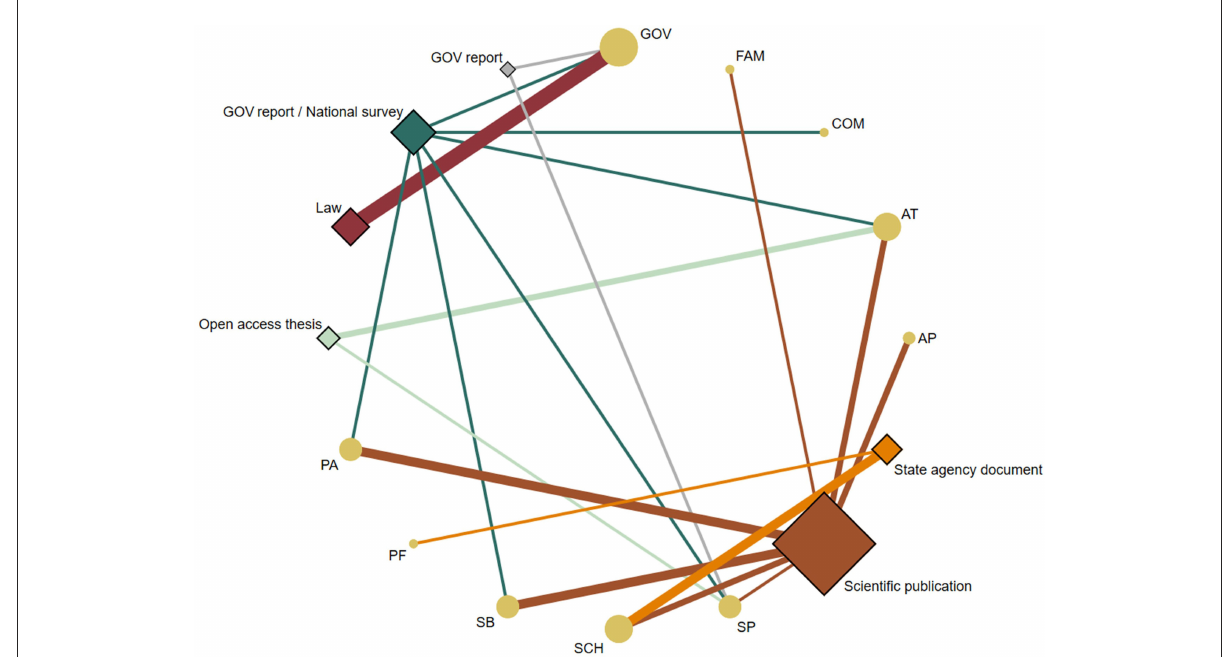
FIGURE3 Network geometry plots of available comparisons between the PA-related indicators and the type of evidence. The size of the circular nodes (PA-related indicators) was relative to the number of papers analyzing these components. The size of the diamond nodes (type of evidence) was relative to the number of available data on PA-related indicators analyzing these components. The width of the solid line connecting the nodes was relative to the number of papers analyzing the PA-related indicators (circular nodes) according to the type of evidence (diamond nodes). AP, Active play; AT, Active transportation; COM, Community and built environment; FAM, Family and Peers; GOV, Government; PA, Physical activity; PF, Physical fitness; SB, Sedentary behavior; SCH, School environment; SP, Sport and physical activity